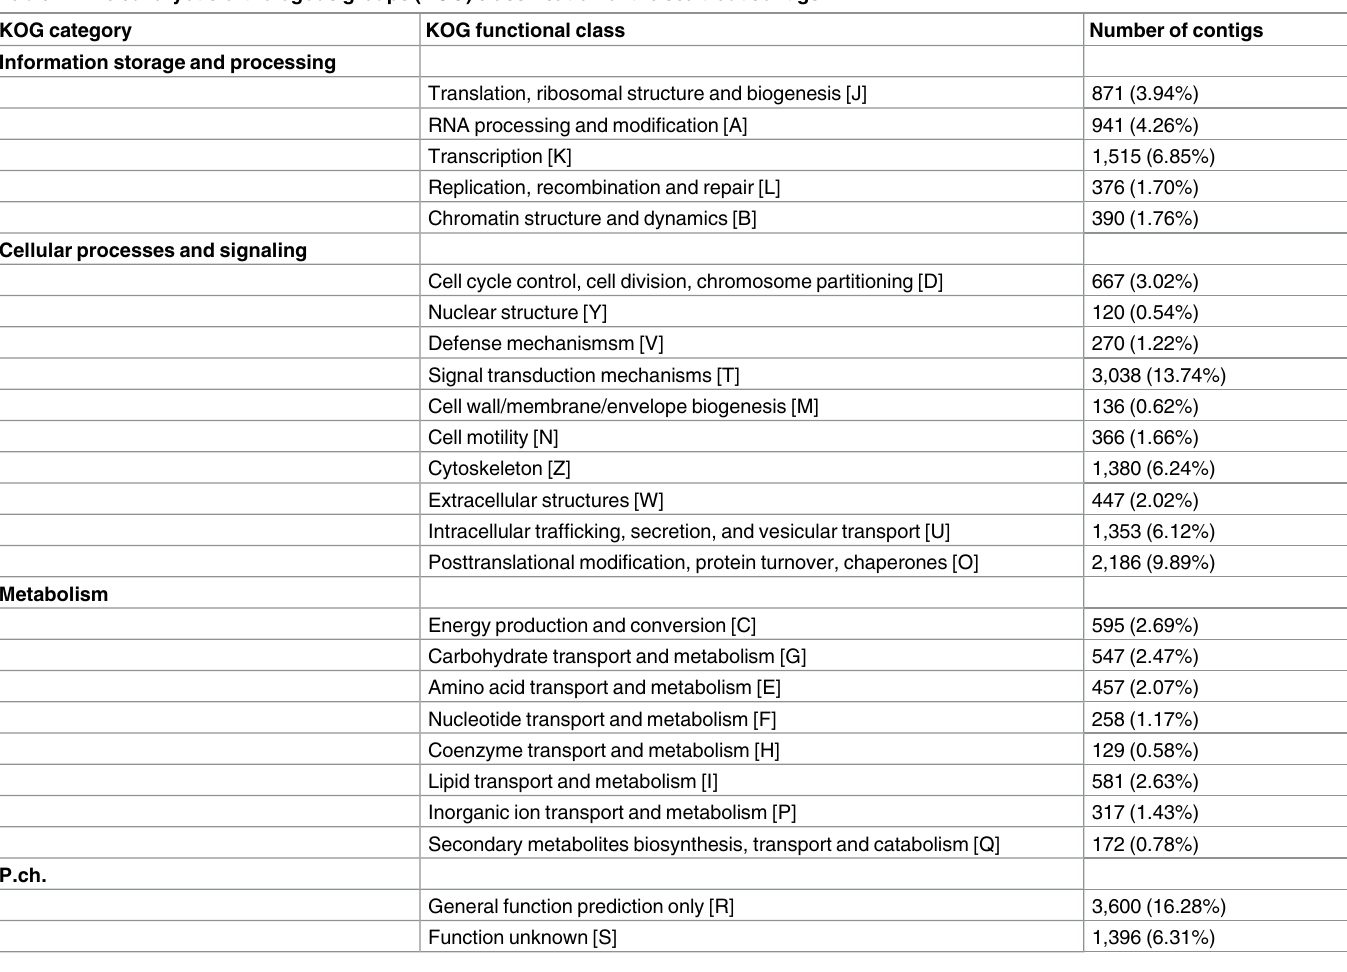
Table 2. The eukaryotic orthologous groups (KOG) classification of the sea trout contigs. KOG